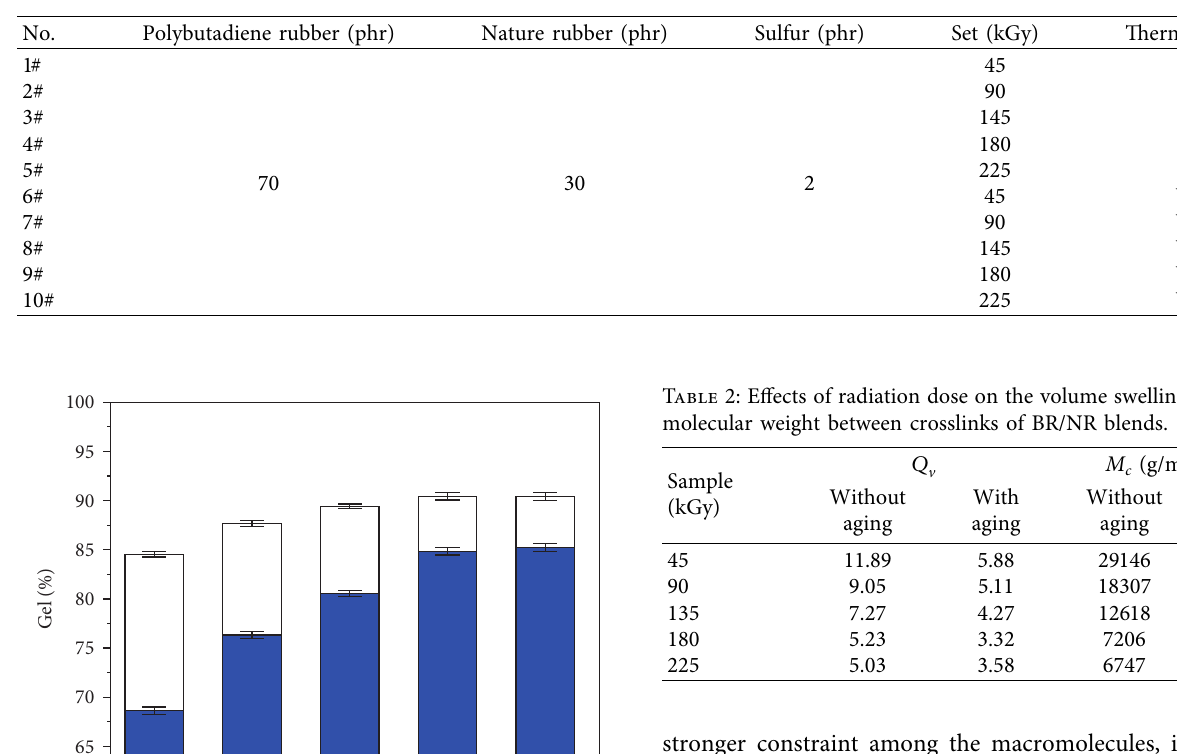
Table 1: The formulation of BR/NR